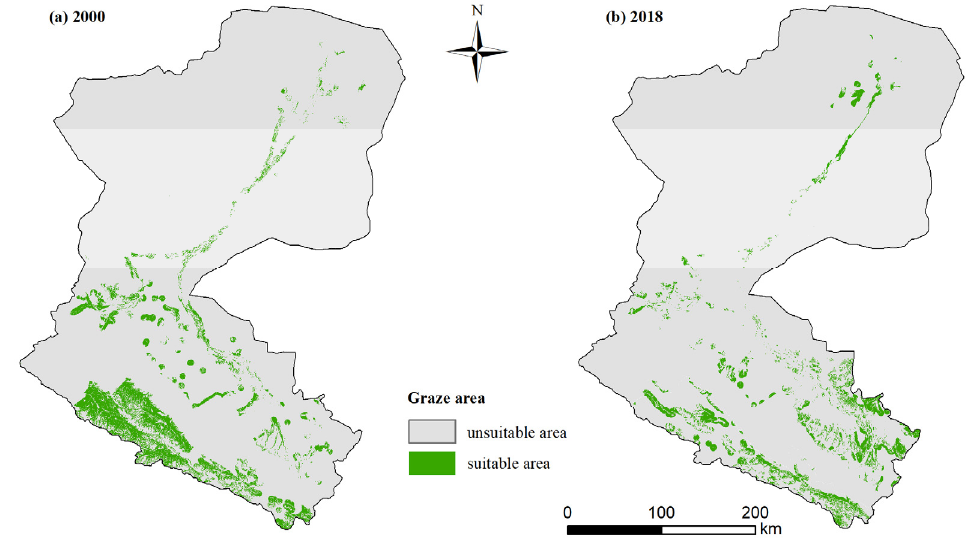
Figure 10. Spatial distribution of grazing suitable and unsuitable areas in ( a ) 2000 and ( b ) 2018.3.5. Identification of Suitable Carrying Capacity.